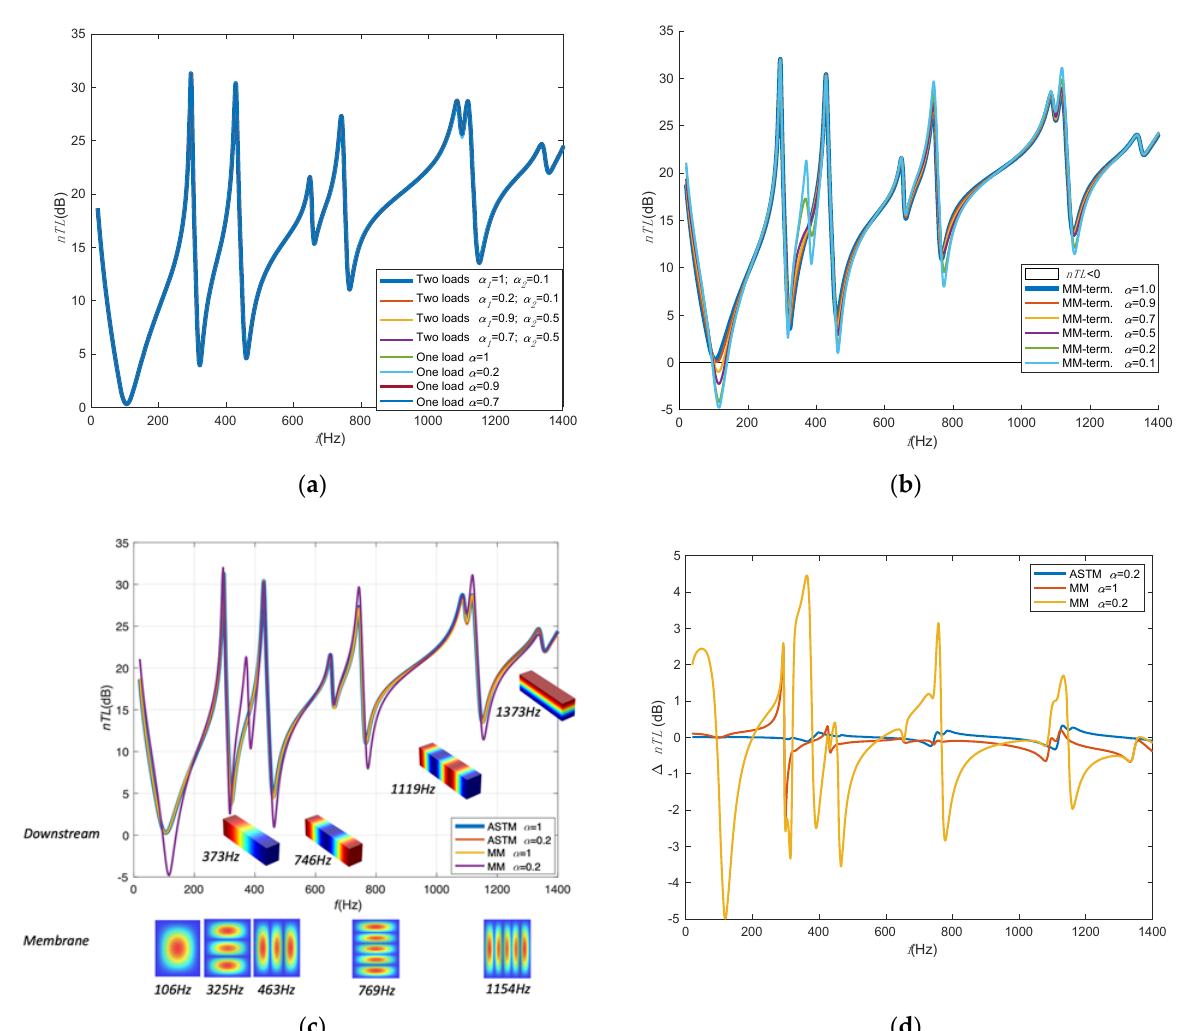
Figure 8. The nTL of 0.5 mm thin membrane determination by means of different methods from the FEM model for six different backing wall sound-absorption terminations (variation of termination (“term.” in the legend) absorption from α = 0.1 to 1) ( a ) ASTM E261109 (“ASTM” in the legend, Transfer matrix method—single or two-load variations with different termination absorptions denoted as α 1 , α 2 for first load and second load variations); ( b ) mobility based method (MM—single load); ( c ) comparison of methods including graphical representation of resonant phenomena causing decreases in the spectrum.; and ( d ) comparison of chosen cases by the difference in the frequency spectra( Δ nTL = nTL i − nTL ASTM α =1 ).